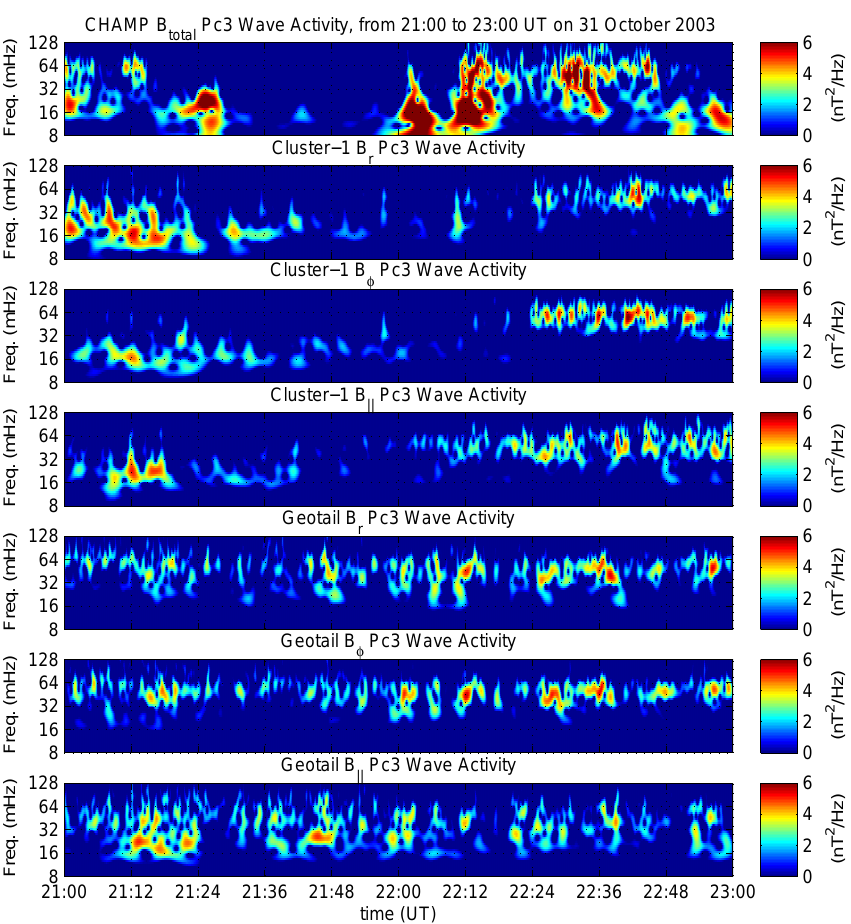
Fig. 13. Event 3: 21:00–23:00UT, 31 October 2003. As in Fig. 11.